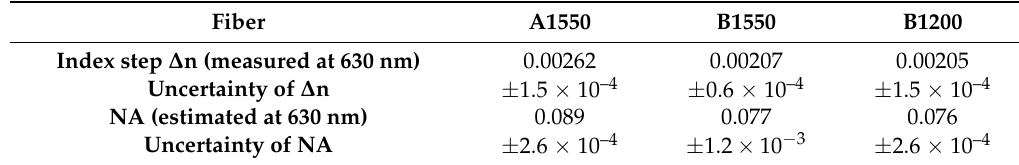
Figure 7. One-dimensional refractive index profile of A1550 fiber (cladding was set to be zero). The scanning line is indicated in Figure 6, in red. Table 2. Refractive index step between doped core and pure silica cladding.